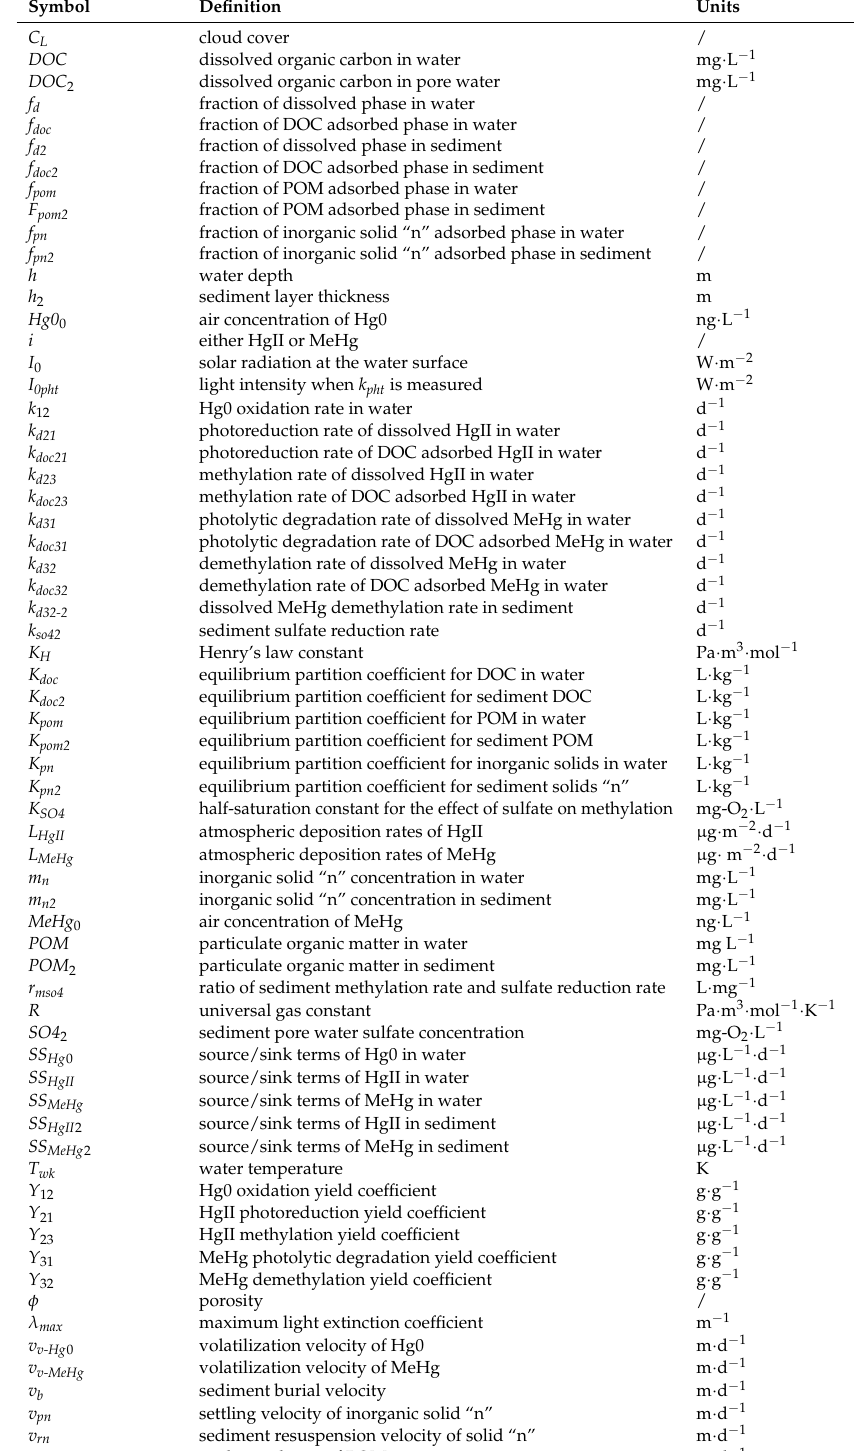
Table 2. Definition of symbols used in Equations